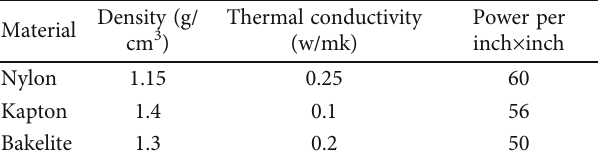
Table 2: Speci fi cation of the material